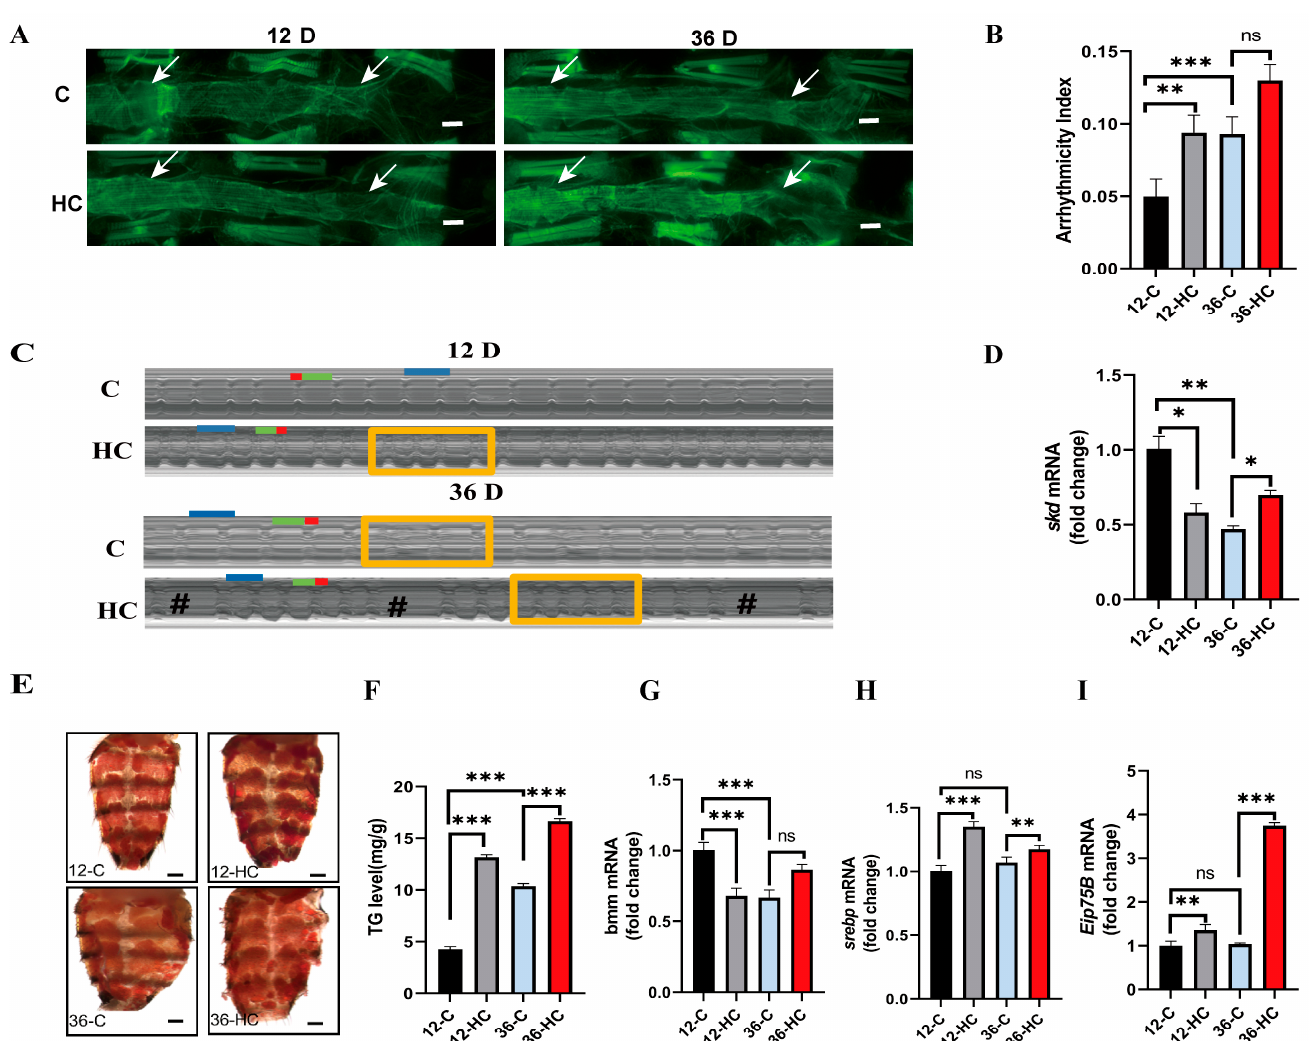
Figure 1. Effects of HFD and aging on cardiac function and systemic TG metabolism in Drosophila . ( A ) Cardiac F-actin staining in W 1118 >Hand-Gal 4 Drosophila . Note: scale bar = 100 µ m, The two white arrows point to the heart of the fruit fly. ( B ) Cardiac function assays included AI in 12-C, 12-HC, 36-C, and 36-HC groups, N = 25 ± 5. ( C ) M-mode ECG. Note: Cardiac cycle—each group of M-mode ECGs was intercepted for 10 s, N = 25 ± 5. HP: horizontal blue line. DI: horizontal green line. SI: horizontal red line, Rectangle for fibrillation, # for cardiac arrest. ( D ) Cardiac skd expression. ( E ) Drosophila Abdominal ORO, scale bar = 250 µ m. ( F ) Systemic TG of W 1118 >Hand-Gal 4 Drosophila . ( G – I ) The cardiac srebp, bmm, and Eip75B mRNA expression levels of 12D W 1118 >Hand-Gal 4 Drosophila . Independent-samples t tests were used to assess differences between 12-C Drosophila and 36-C Drosophila ; 12-C Drosophila and 12-HC Drosophila ; 36-C Drosophila and 36-HC Drosophila . The data represent the mean, and the error bars represent SEM. ns p > 0.05; * p < 0.05; ** p < 0.01; *** p < 0.001.